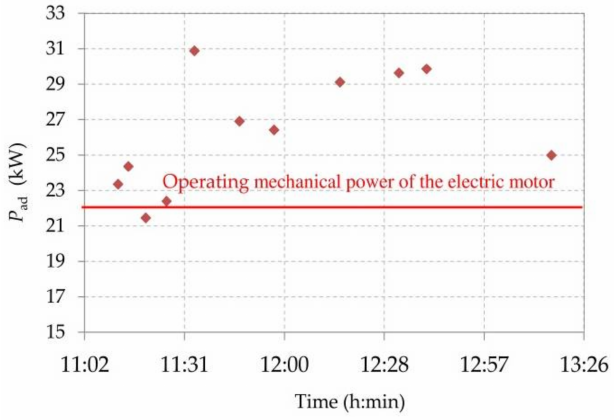
Figure 19. Values of the required mechanical power at adiabatic